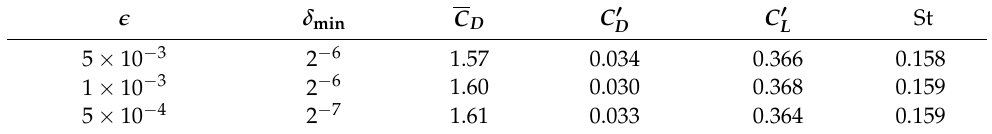
Table 3. WA-DNS of square cylinder flow: integral results for different wavelet